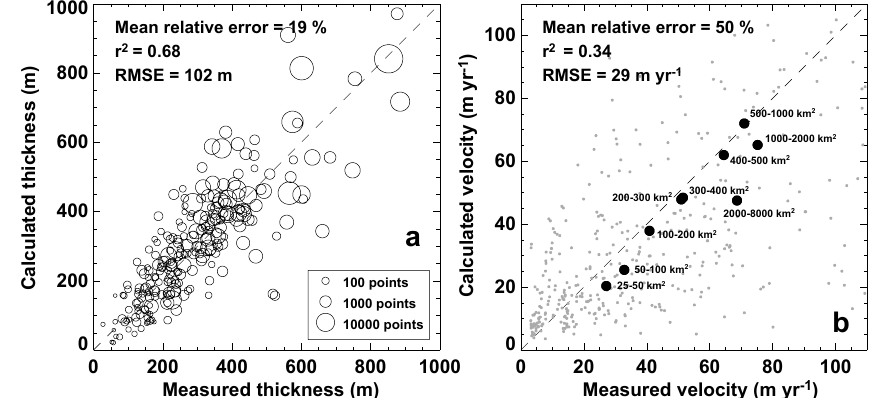
Figure 4. Validation of calculated glacier-specific (a) mean ice thickness (average over all OIB data points) and (b) mean surface flow velocity against measurements. The mean relative error, the correlation coefficient r 2 and the root-mean-square error (RMSE) are given. The size of the symbols in (a) is proportional to the number of measurements within the glacier catchment. Solid dots in (b) indicate average flow speeds for glacier size classes.